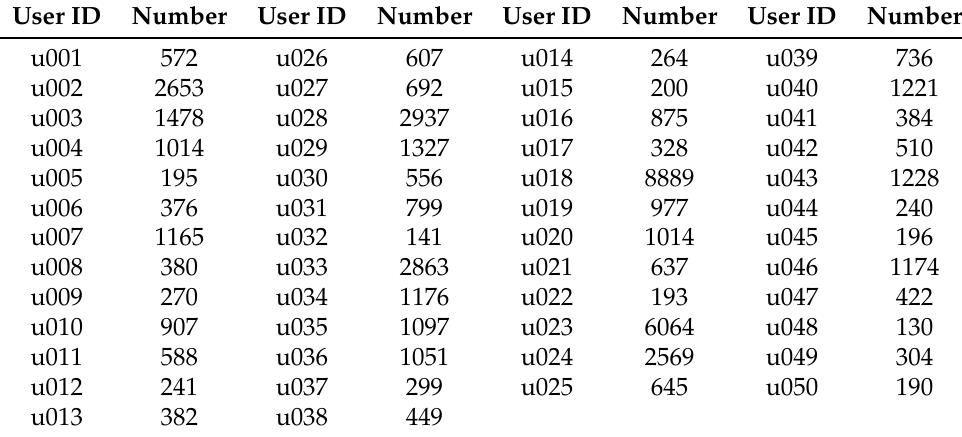
Table 4. The number of gait data for each